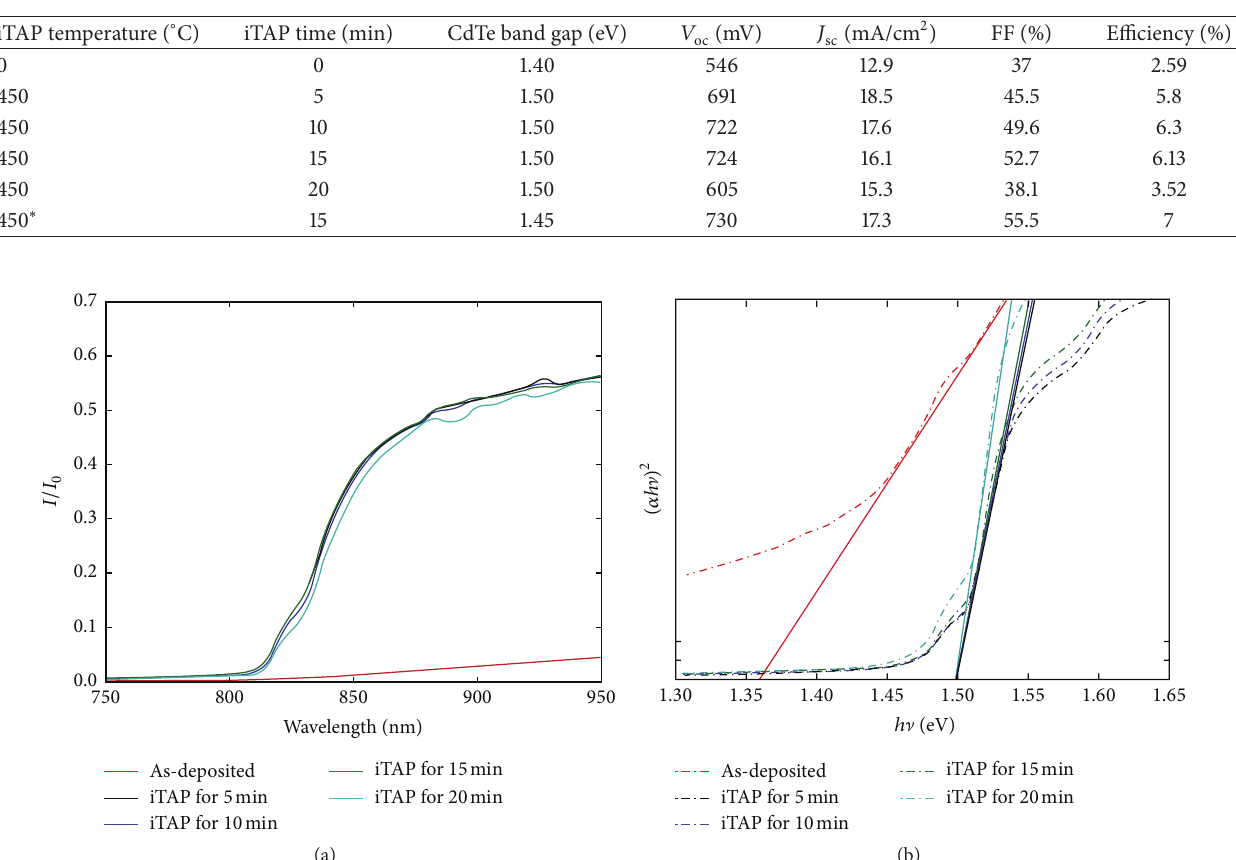
Figure 5: (a) Transmittance spectra and (b) band gap approximation of CdTe thin films treated at different iTAP durations.